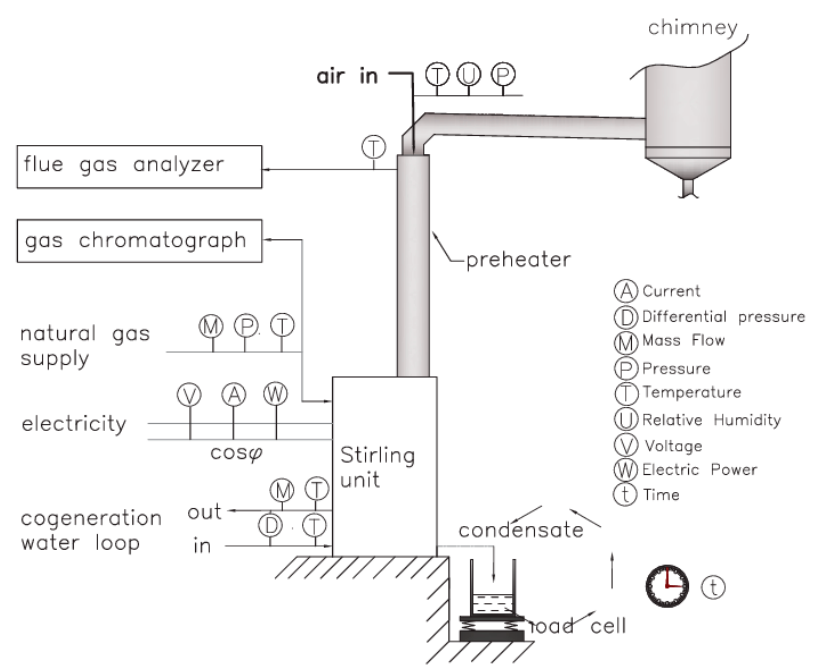
Figure 1. Schematic of the experimental setup showing the measurements acquired externally to the Stirling unit under testing of on–off cycling operation.